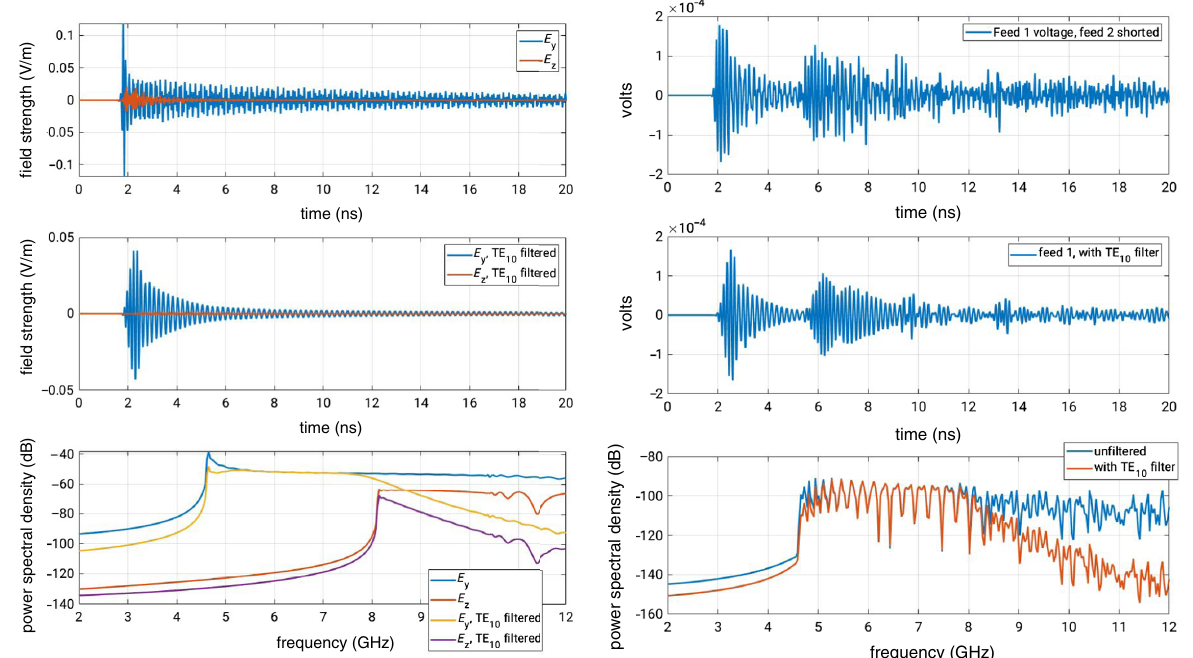
FIG. 5. Left column: FDTD-simulated electric fields for the as-built ACE element at a point just prior to the end of the waveguide. For these, the reflection from the shorted far end has been suppressed. Left top: the raw induced waveform with no TE 10 passband filtering imposed; blue is the TE transverse mode and red is the parasitic longitudinal mode. Left middle: same as left top, with a 5 – 8 GHz mn filter applied. Left bottom: power spectral density of each of the signals shown above. Right: the same sequence of signals is shown after coupling through the waveguide-to-coaxial adapter and now including the reflection from the shorted end. Imperfections in the impedance matching are included at each end to produce a realistic signal. The power spectra (right bottom) show a high degree of modulation due to the effects of the Fourier transform of the double